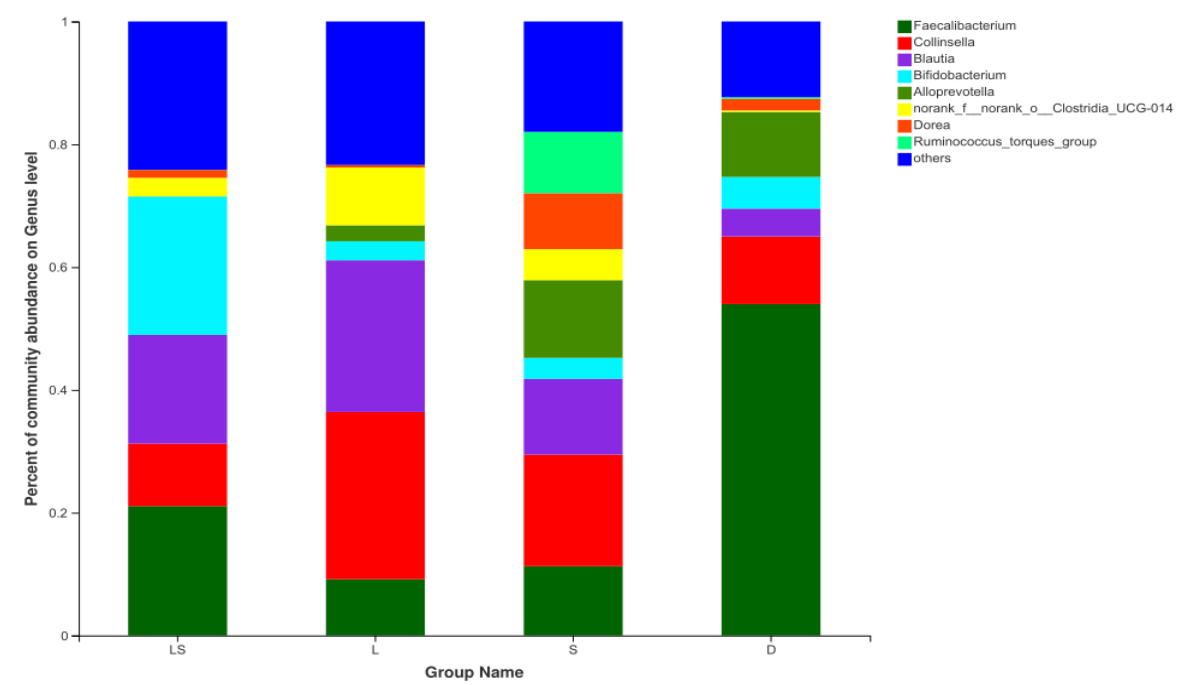
Figure 3. Relative abundance of bacterial groups from the LS, L, S, and D groups at the genus level. LS group: lactic acid bacteria + yeast group; L group: lactic acid bacteria group; S group: yeast group; D group: control group.